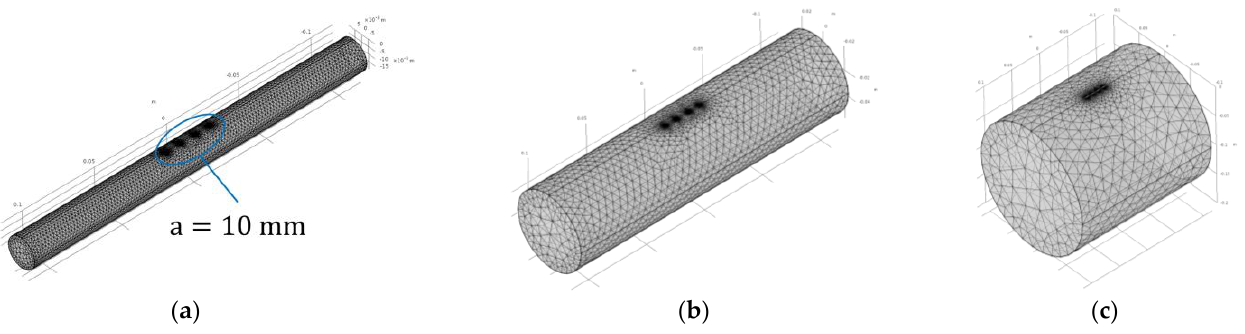
Figure A3. Cylindrical models with different ratios of radius to interelectrode distance: ( a ) R/a = 1, ( b ) R/a = 3, ( c ) R/a = 10.